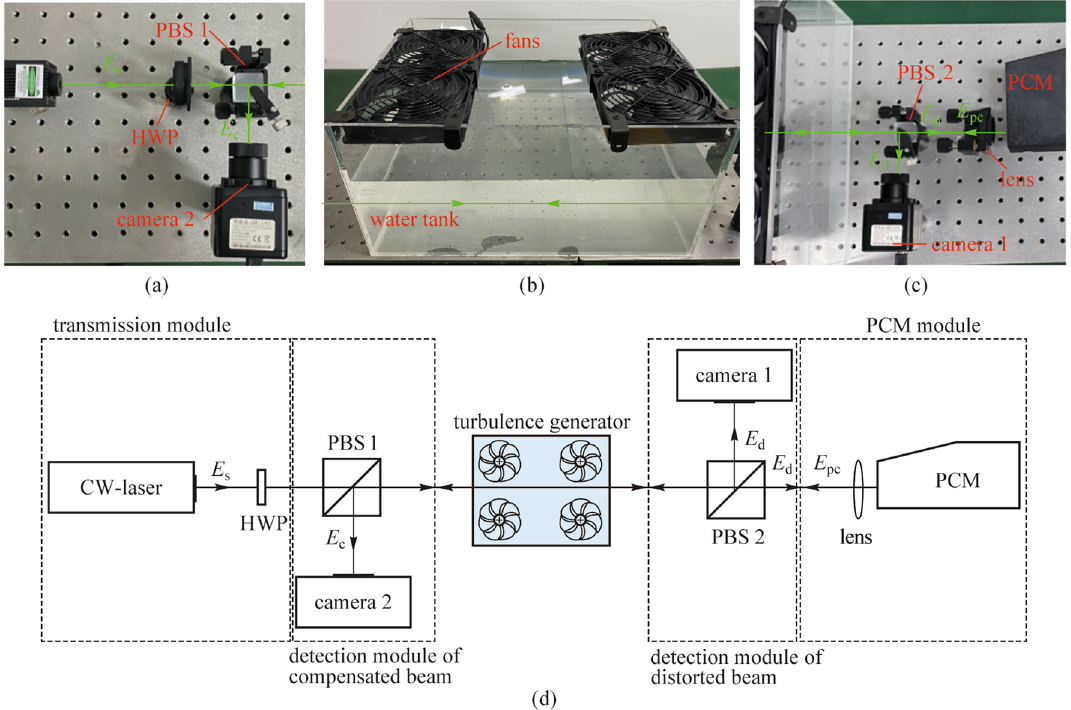
Fig. 2 Experimental setup for beam drift correction caused by surface wave turbulence. E s , source beam, E d , distorted beam, E pc , phase-con- E , compensated beam. a Transmission module and detection module of compensated beam. b Turbulence generator. c PCM jugate beam, and c module and detection module of distorted beam. d Schematic of the experimental